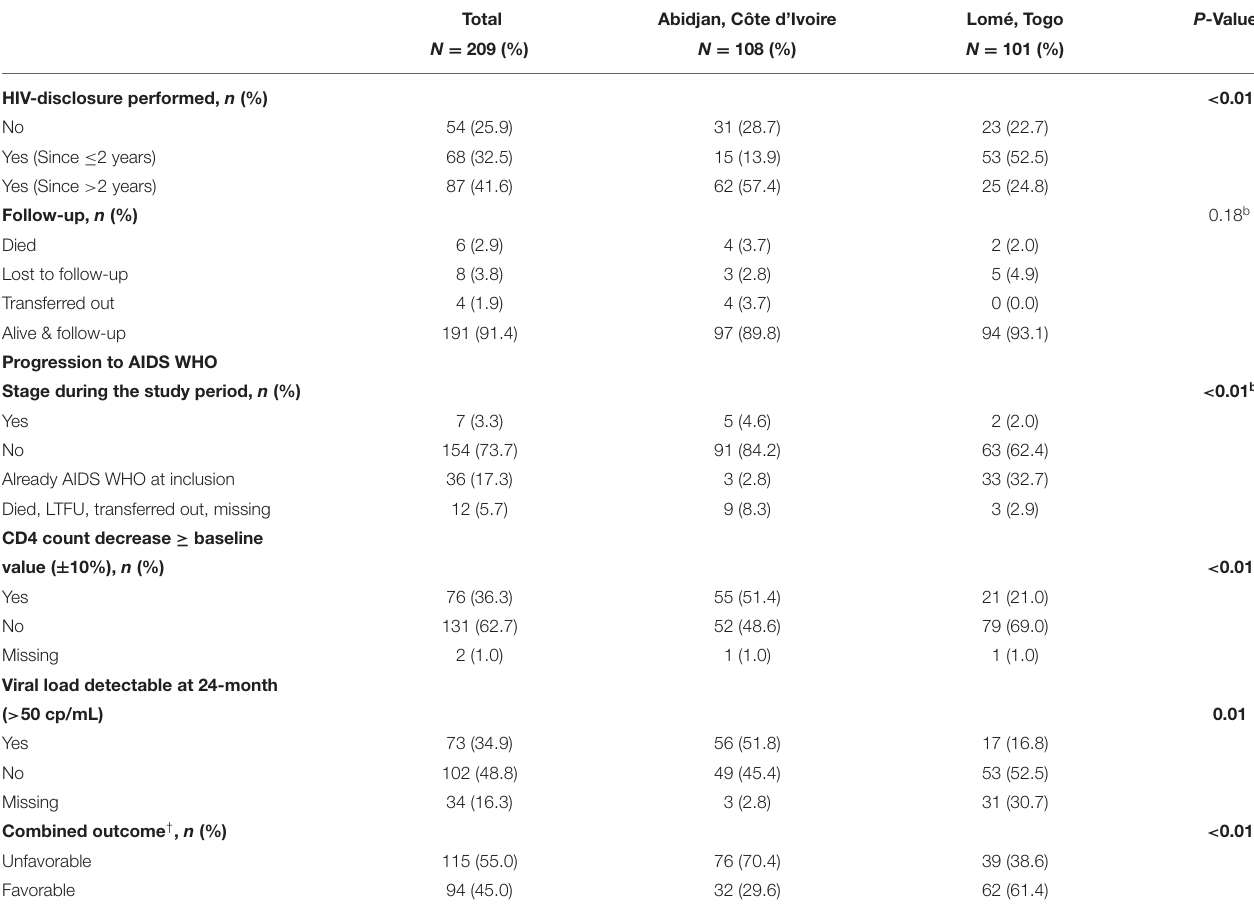
TABLE 6 | 24-month component and combined outcomes of the 209 adolescents living with perinatally-acquired HIV included, by sites in the COHADO cohort, IeDEA-pWADA, 2015–2017. Total Abidjan, Côte d’Ivoire Lomé, Togo P -Value